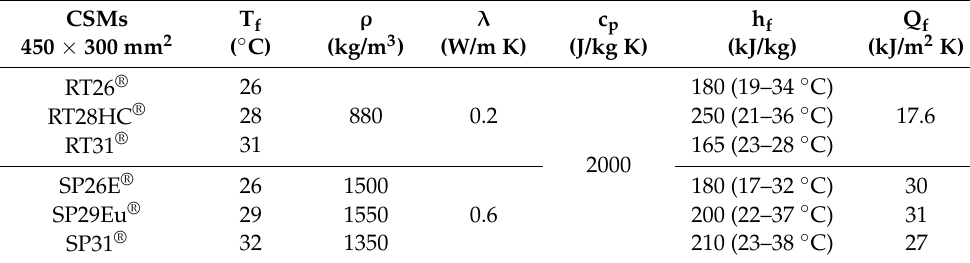
Table 3. Properties of macroencapsulated